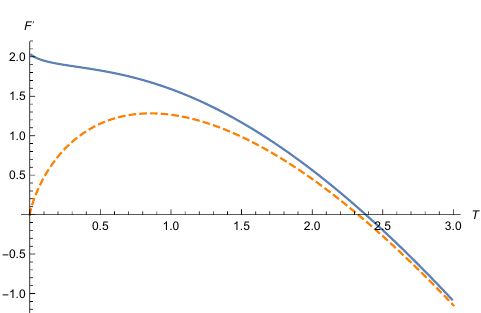
Figure 1. Plot of the genus-zero free energy for the Airy case. The vertical and the horizontal axes are the rescaled free energy F 0 = ~ − 2 / 3 F and the rescaled temperature T 0 = ~ − 2 / 3 T , respectively. The blue solid curve represents the quenched free energy in (3.27) while the orange dashed curve is the annealed free energy in